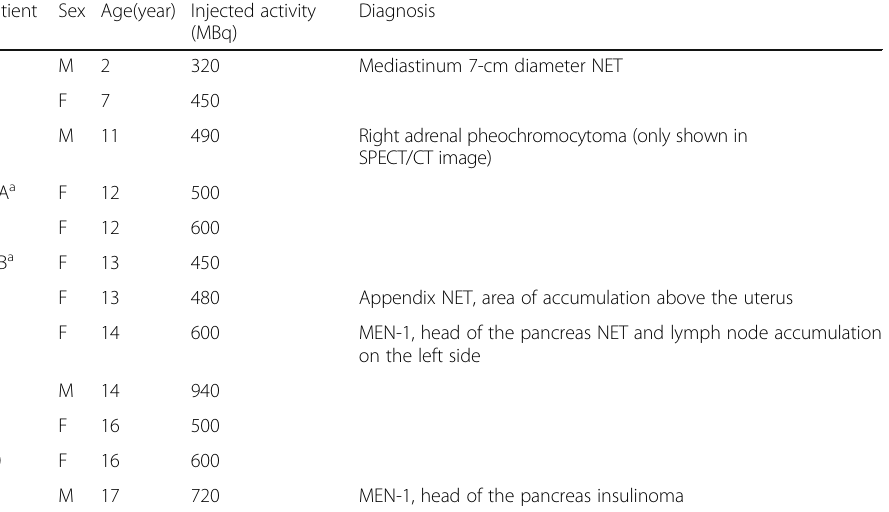
Table 1 Demographic information of children patients involved in this study, sorted by age Patient